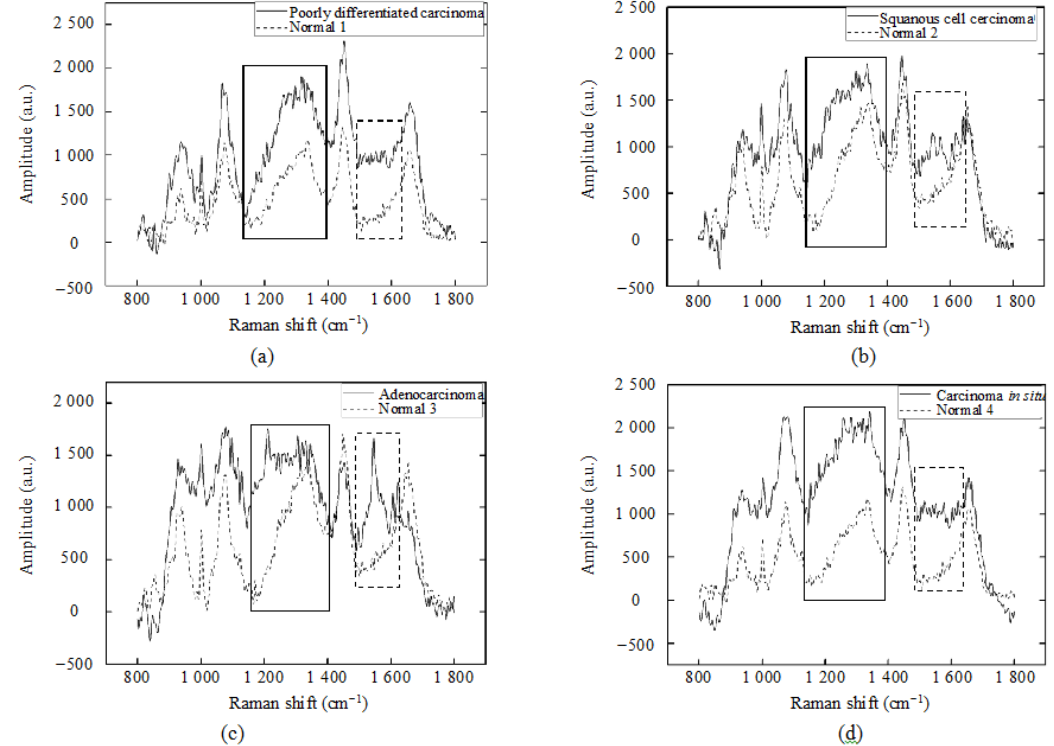
Fig. 4 Raman spectra of (a) the poorly differentiated carcinoma and normal tissues, (b) squamous cell carcinoma and normal tissues, (c) adenocarcinoma and normal tissues, and (d) carcinoma in situ and normal